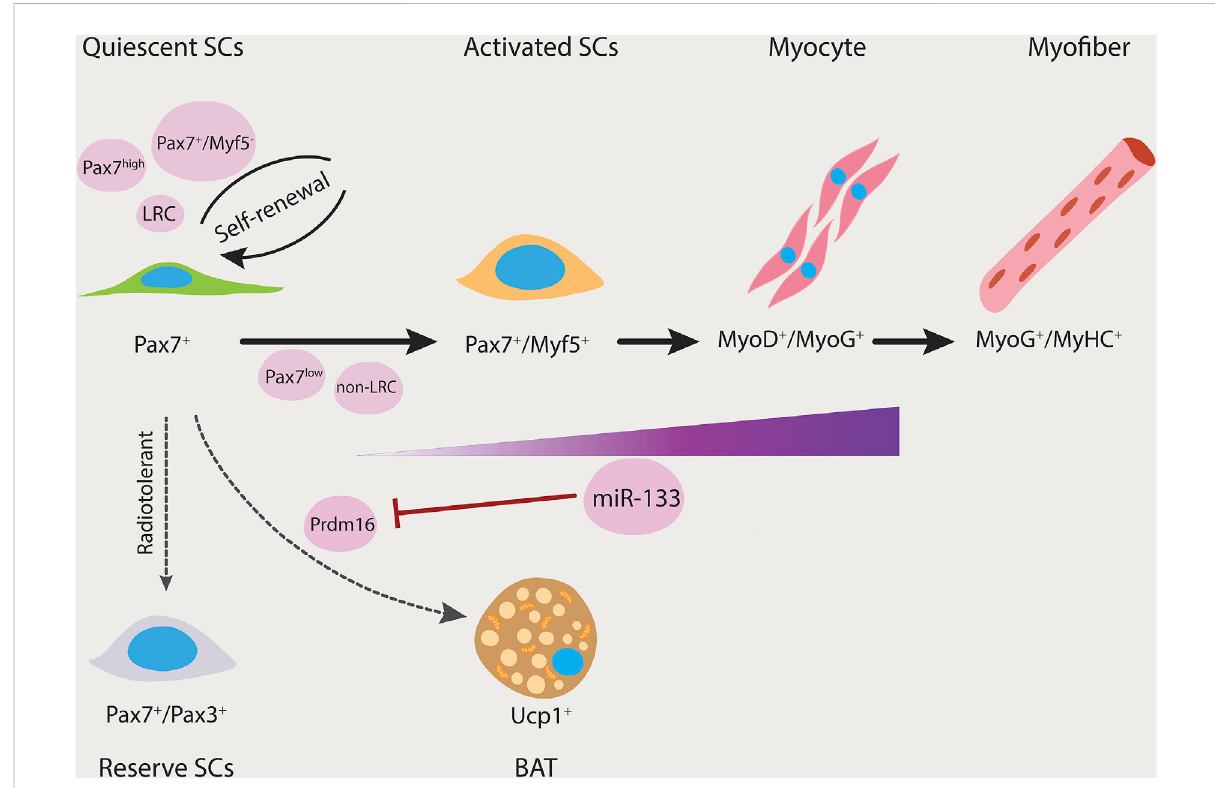
FIGURE 1 Satellite cell heterogeneity. Satellite cells can give rise to both myogenic and brown adipogenic lineages. miR-133 expression is upregulated as the myogenic program progresses. Prdm16 regulates satellite cell differentiation into brown adipocytes and its expression is inhibited by miR-133. Thereby, miR-133 controls brown adipose determination (dashed arrow). Subsets of satellite cells have differing functional potential (black arrows). Pax7 + /Myf5 − ,Pax7 high ,andlong-termlabel-retainingpopulationshavetheabilitytorepopulatethestemcellpool.Furthermore,Pax7 + /Pax3 + isa rare subpopulation that is resistant to radiation and contains reserve stem cell properties. LRC, label-retaining cells; non-LRC, non-label-retaining cells; SCs, satellite